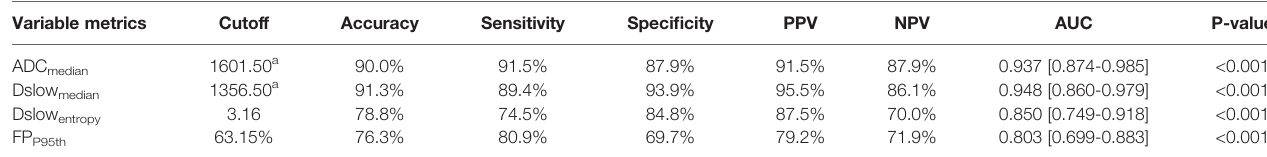
TABLE 4 | The diagnostic performance of the independent in fl uencing factors for the well/moderately differentiated vs. poorly differentiated GC. Variable metrics